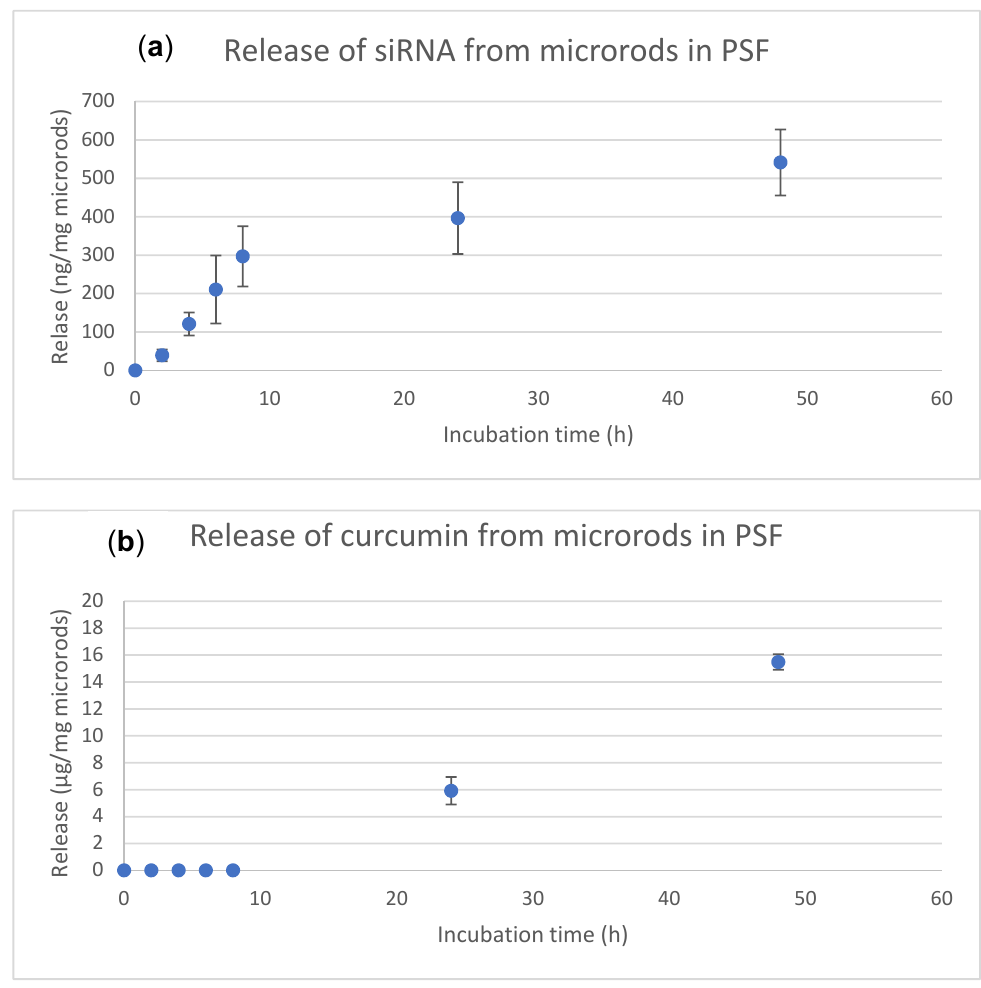
Figure 3 . In vitro release kinetics of siRNA ( a ) and curcumin ( b ) in PSF for 48 h at 37 °C under gentle shaking. The release profiles show that the two drugs were released with different kinetics. The curcumin, which was located in the pores of the mSNPs and covered by various polymers, was only detected after 24 h. After two days, 15 µg per mg rods were released, which is about 8% of the total load. The siRNA found on the surface of the microrods was released continuously with a final amount of about 540 ng per mg microrods after 48 h, which is about 15% of the load. For each time point, three individual experiments were performed and the mean values as well as standard deviation were determined (n = 3).